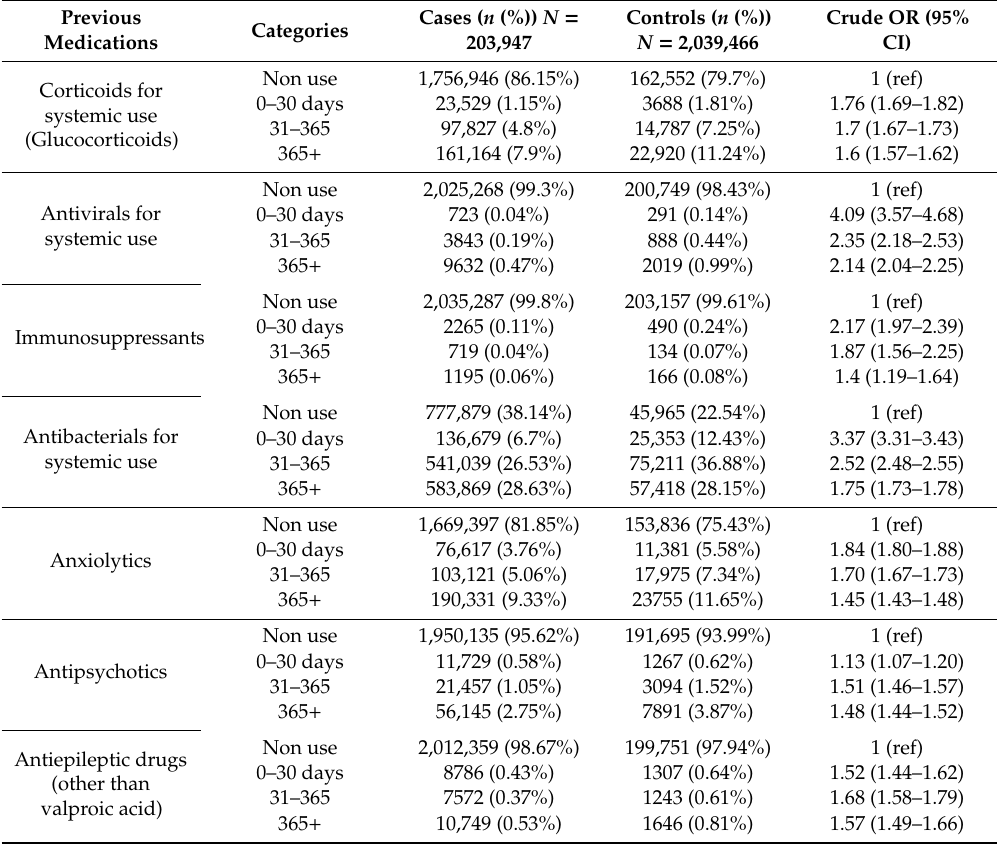
Table 4. Previous medication use between cases and